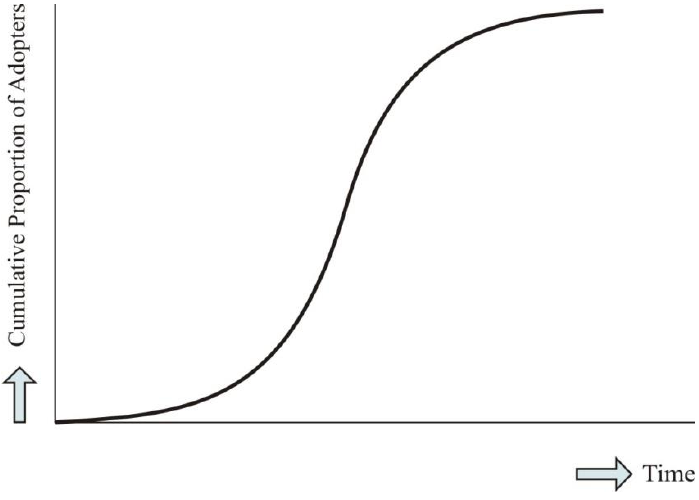
Figure 4. Cumulative diffusion curve (Source: Rogers,